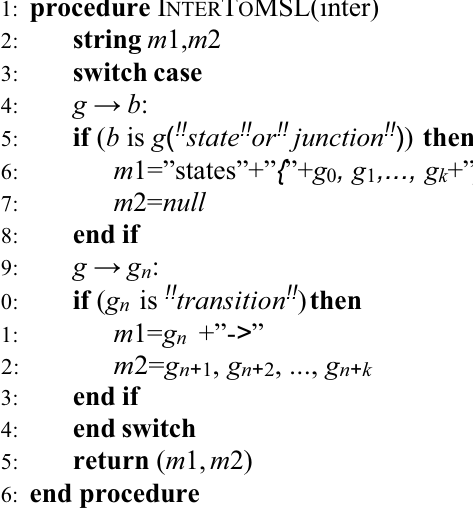
Fig. 5. Intermediate file to MSL